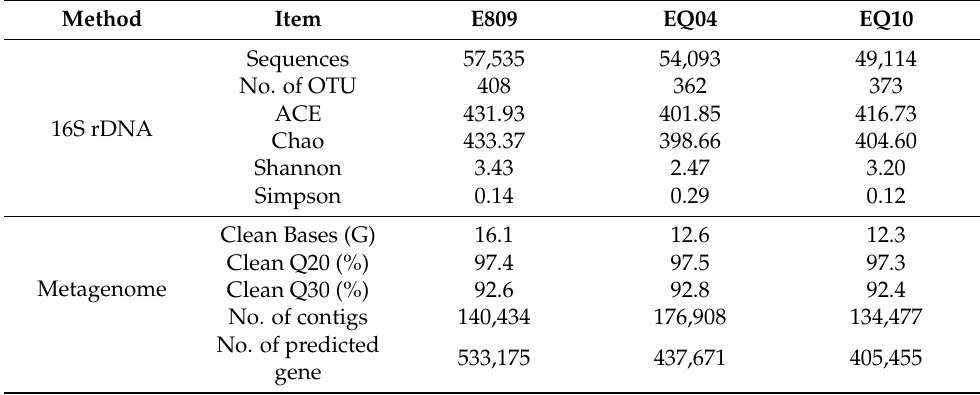
Table 2. Metagenome and 16S rDNA and sequencing information and microbial diversity index.